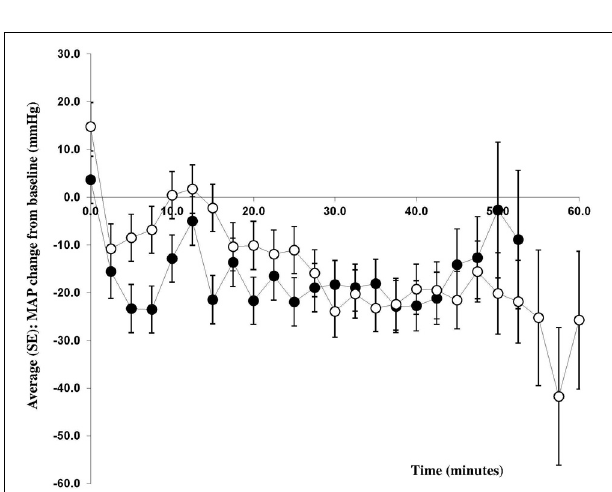
FIGURE 3 | Change in mean arterial pressure from baseline. Changes in mean arterial blood pressure (MAP) from baseline (mmHg) during caesarean section with spinal anesthesia. Patients received either phenylephrine ( n = 12; open circles) or ephedrine ( n = 12; black circles).